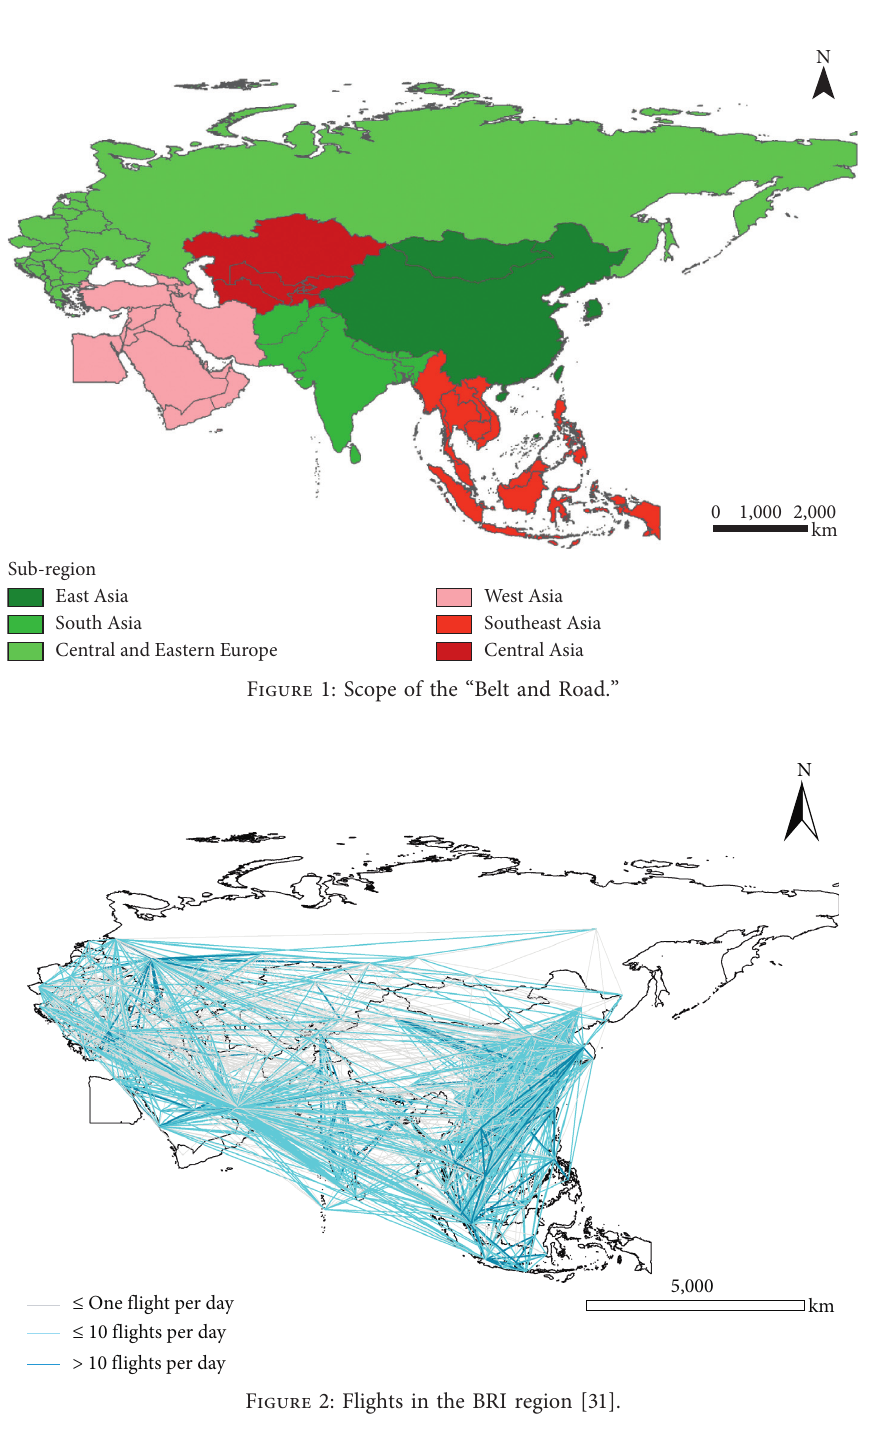
Figure 2: Flights in the BRI region [31].